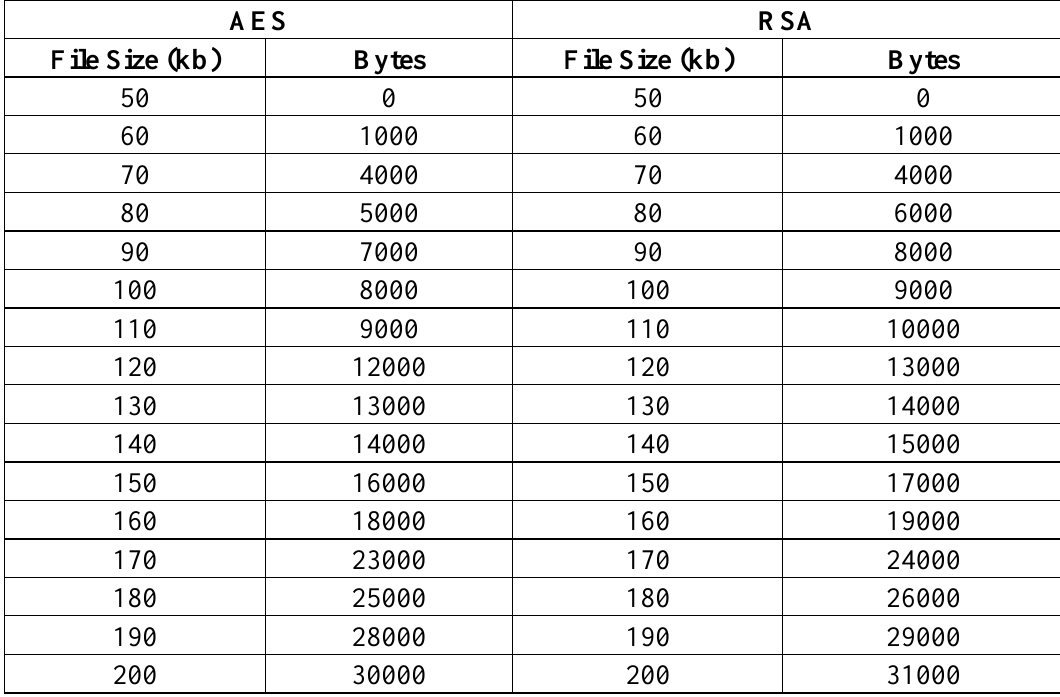
Table 3. Memory Usage of AES and